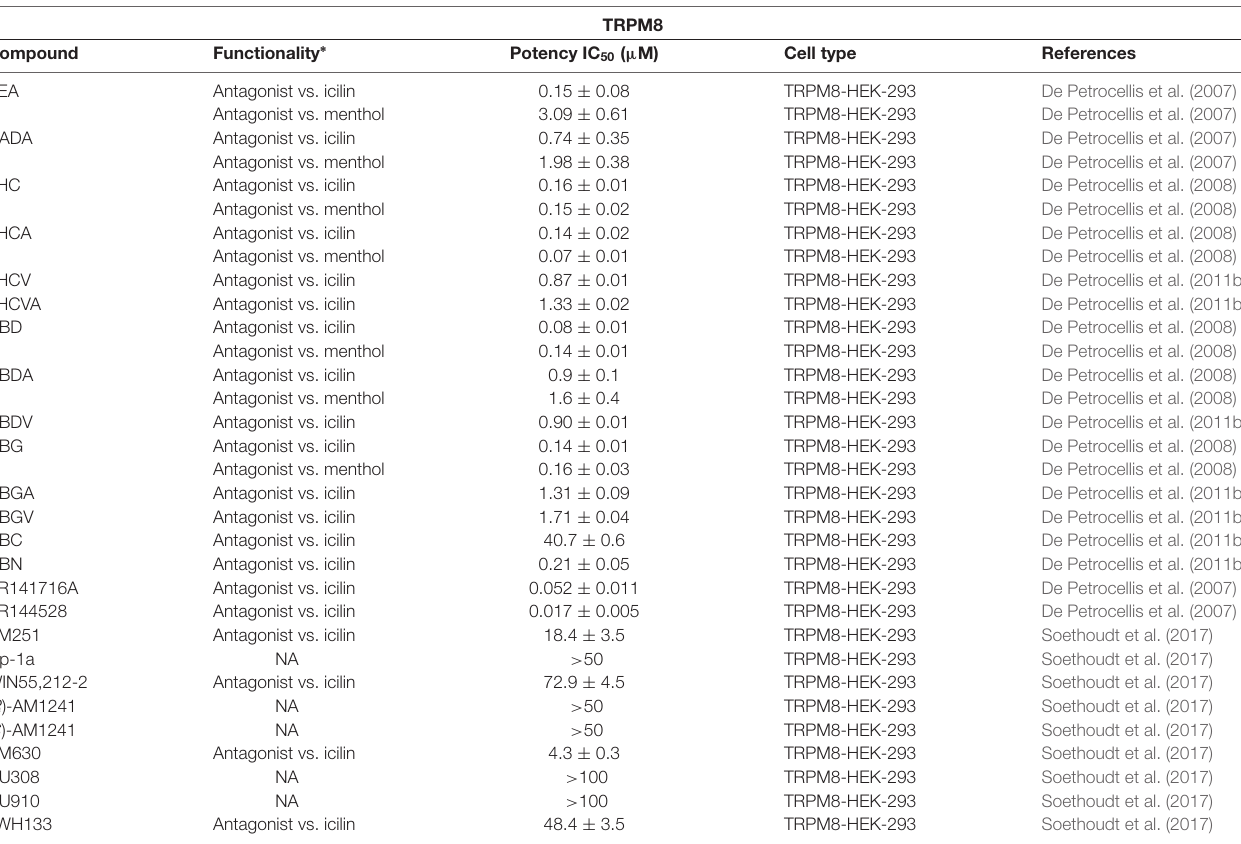
TABLE 6 | Functionality of phytogenic, endogenous, and synthetic cannabinoid ligands at